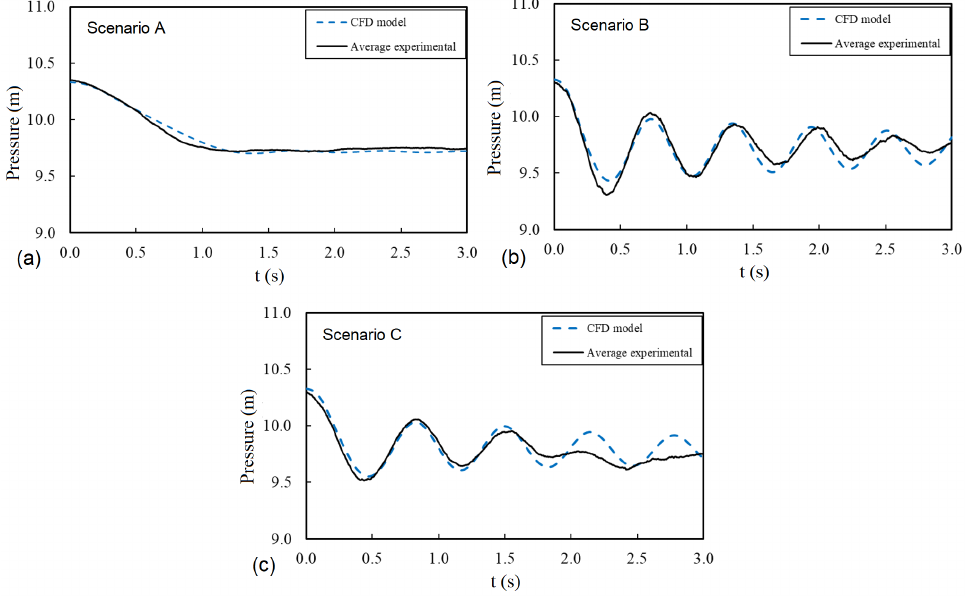
Figure 10. Pressure oscillation patterns for different draining scenarios: ( a ) with an equally distributed air pocket and partial opening of the valve; ( b ) with an equally distributed air pocket and total opening of the valve; ( c ) with an unequally distributed air pocket and total opening of the